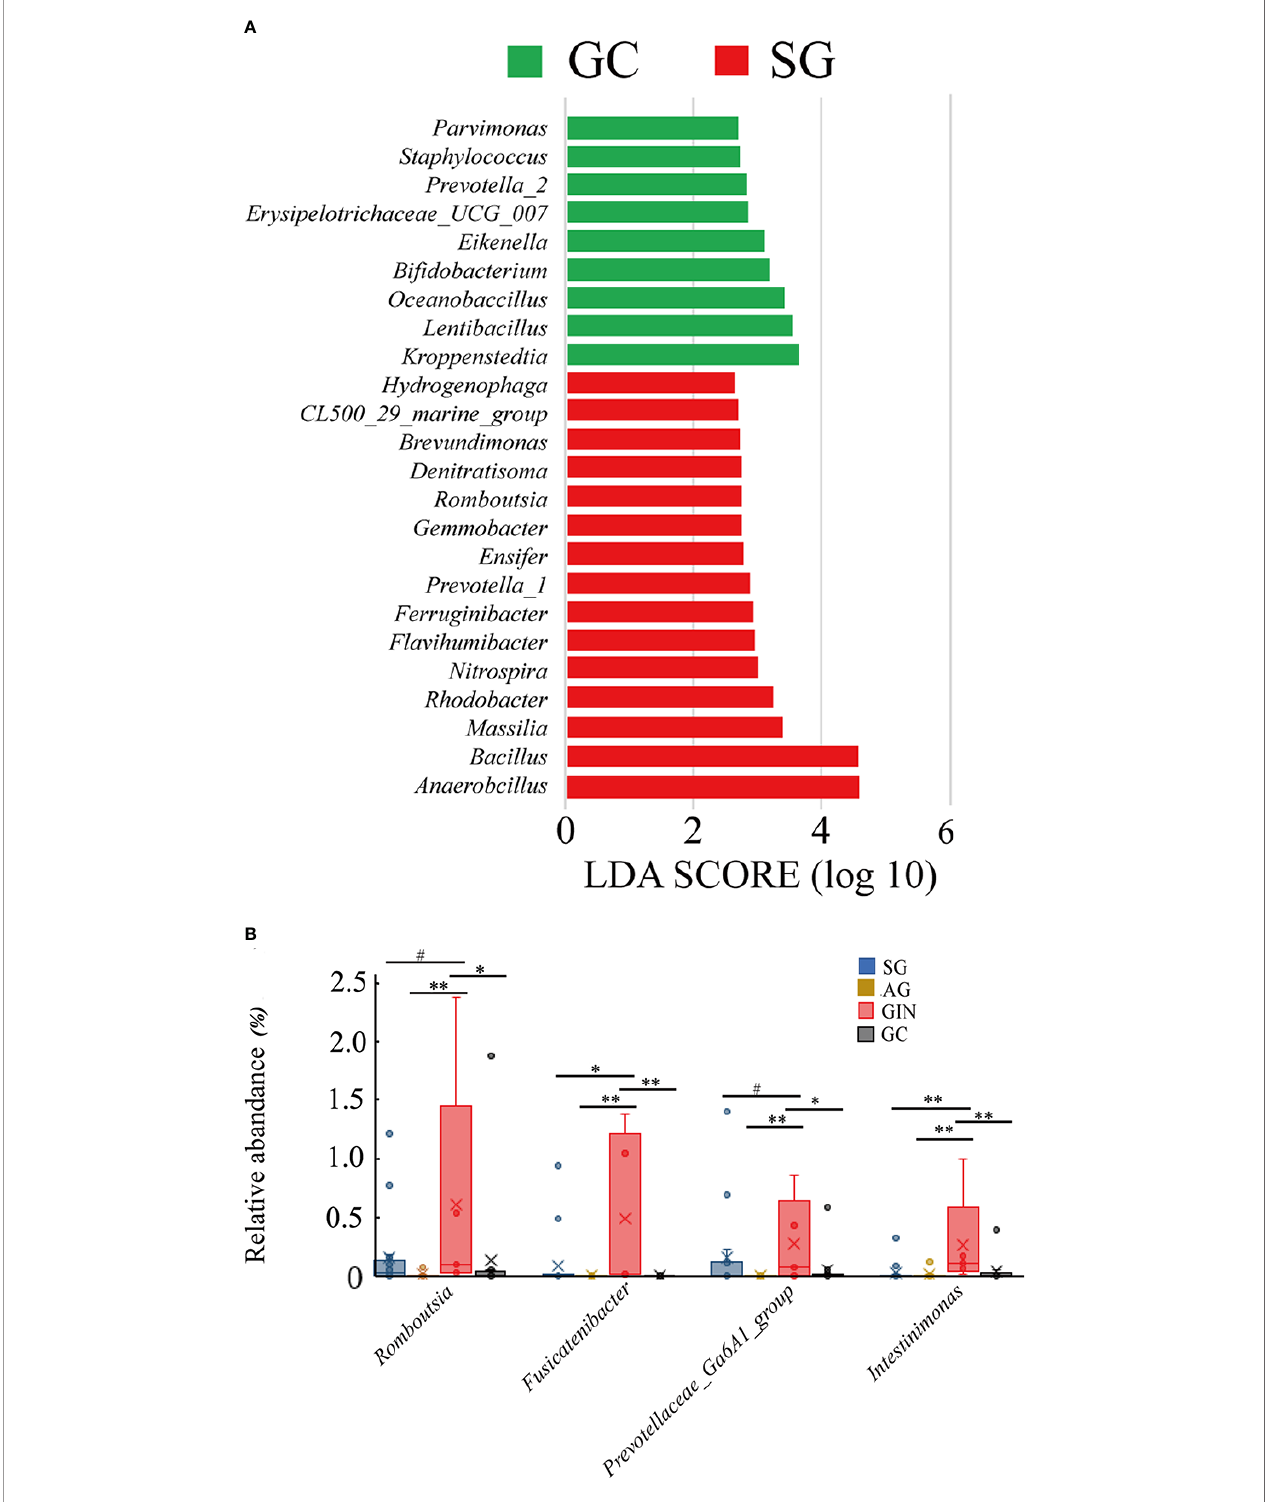
FIGURE 3 | Speci fi c genera associated with gastric cancer and gastric intraepithelial neoplasia. (A) Histogram of the linear discriminant analysis (LDA) scores for differentially abundant genera between gastric cancer (GC) and super fi cial gastritis (SG) groups. Signi fi cance obtained by LDA effect size (LEfSe) at p < 0.05 (Kruksal – Wallis test) and LDA score>2. (B) The relative abundance of GIN-enriched genera in four groups (Wilcoxon test, # p ≥ 0.05, *0.01 ≤ p <0.05, ** p